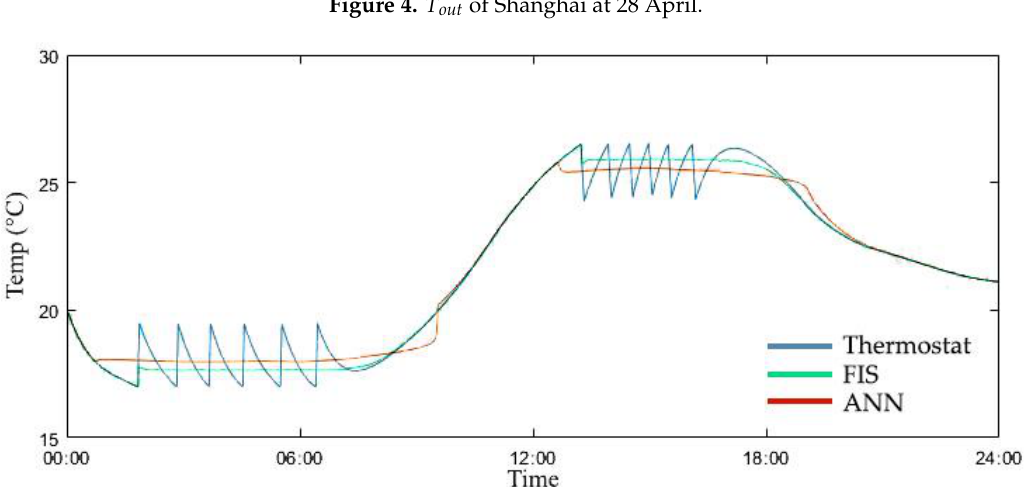
Figure 4. T out of Shanghai at 28 April.